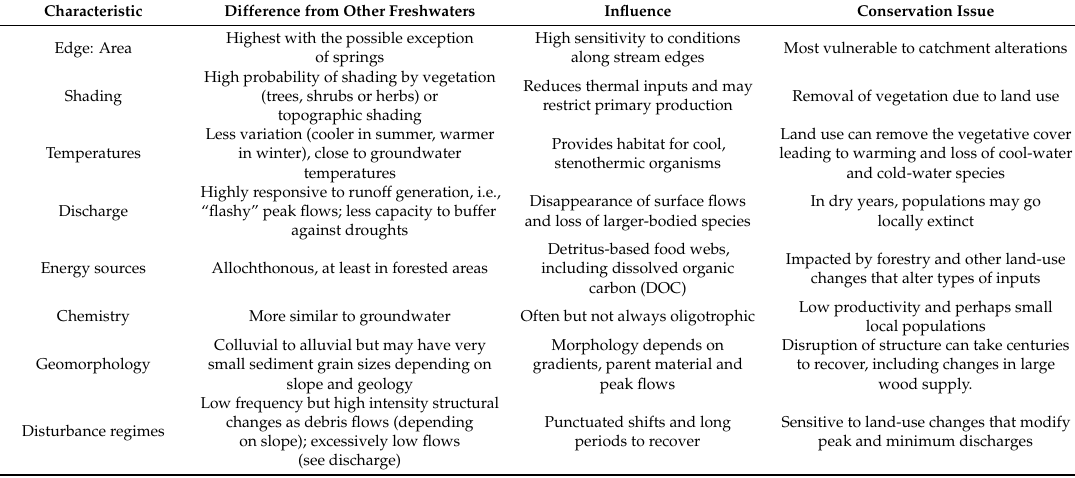
Table 1. The characteristics that distinguish headwater streams from other freshwaters: Small size and small volume are not included, as those are implied by the definition of headwater streams. These characteristics are generalizations, and there is variation across